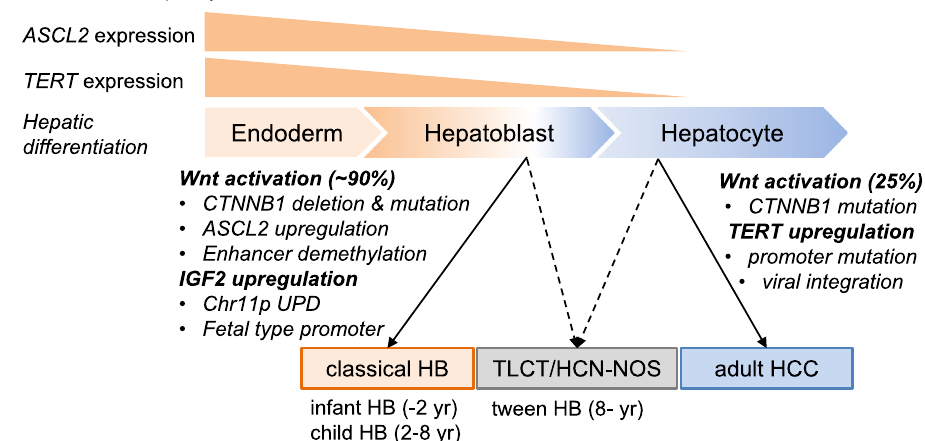
Fig. 6 Overview of childhood and adult liver malignancies characterized by molecular aberrations and “ cell of origin ” . During the process of cell differentiation and maturation from de fi nitive endoderm to hepatoblast and hepatocyte, the expression of ASCL2, a stem cell-related factor, and TERT, an immortality-related gene, is decreased, as well as the self-renewal capacity. Classical hepatoblastoma (HB), derived from hepatoblasts show high activation of Wnt and sustained upregulation of IGF2 due to genetic and epigenetic abnormalities, while adult hepatocellular carcinoma (HCC), derived from mature hepatocytes with low TERT expression, show its upregulation due to promoter mutations and viral integration. Wnt activation (25%) is mostly due to mutations in CTNNB1 . TLCT/HCN-NOS shows combined features of both tumors. TERT: telomerase reverse transcriptase, TLCT: translational liver cell tumor, HCN-NOS: hepatocellular malignant neoplasm, not-otherwise-speci fi